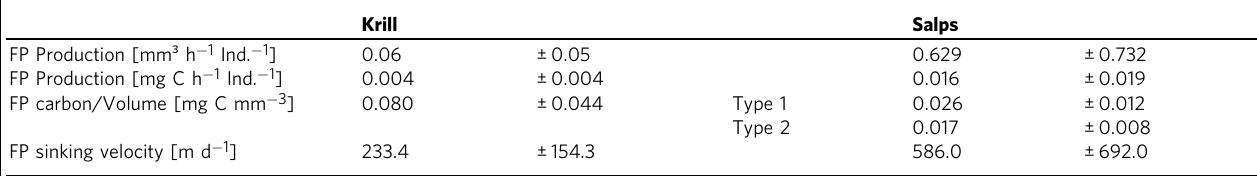
Table 3 Faecal pellet (FP) parameters for Antarctic krill ( Euphausia superba ) and salps ( Salpa thompsoni ). Krill Salps